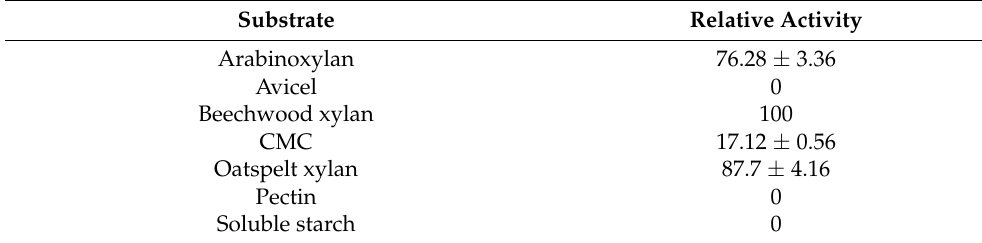
Table 6. Substrate specificity of Beauveria bassiana SAN01 xylanase.